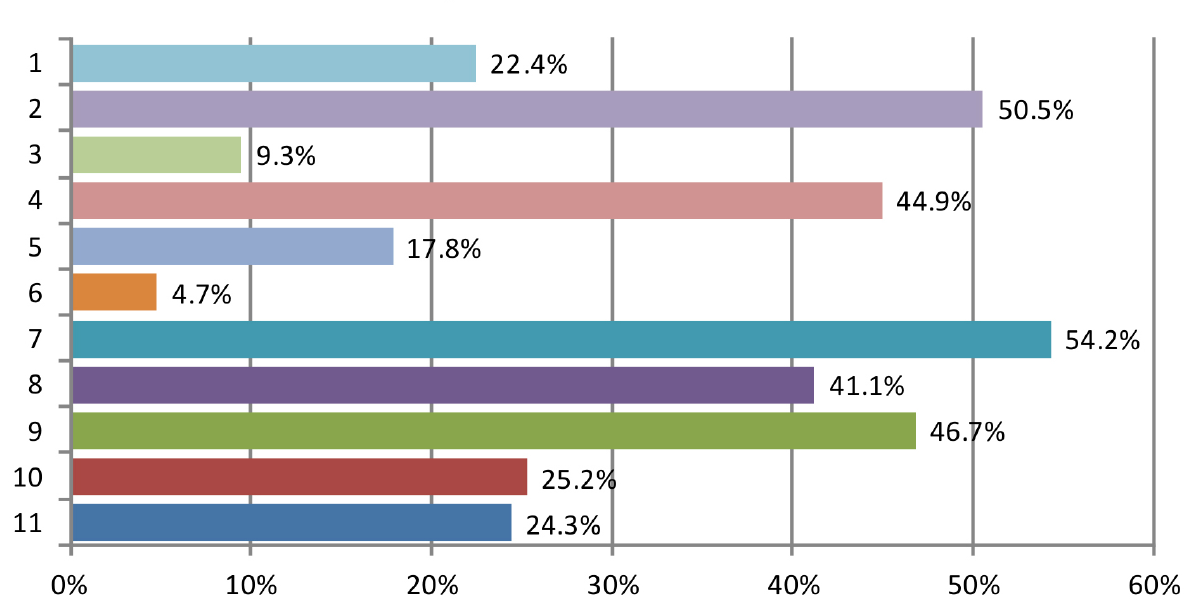
Figure 2. Reasons for not using computerized systems in clinics. x-axis: 1=Cost concerns (Setup/ maintenance); 2=Computer use is more time-consuming; 3=Not supported by the practice partners/ practice organization; 4=Concerns on data migration from paper to system; 5=Insufficient space for computer installation; 6=System not support Chinese language; 7=Not patient-friendly during consultations. 8. Inconvenience caused during down-time 9. Lack of technical support 10. Concerns on computer hackers 11. Others.